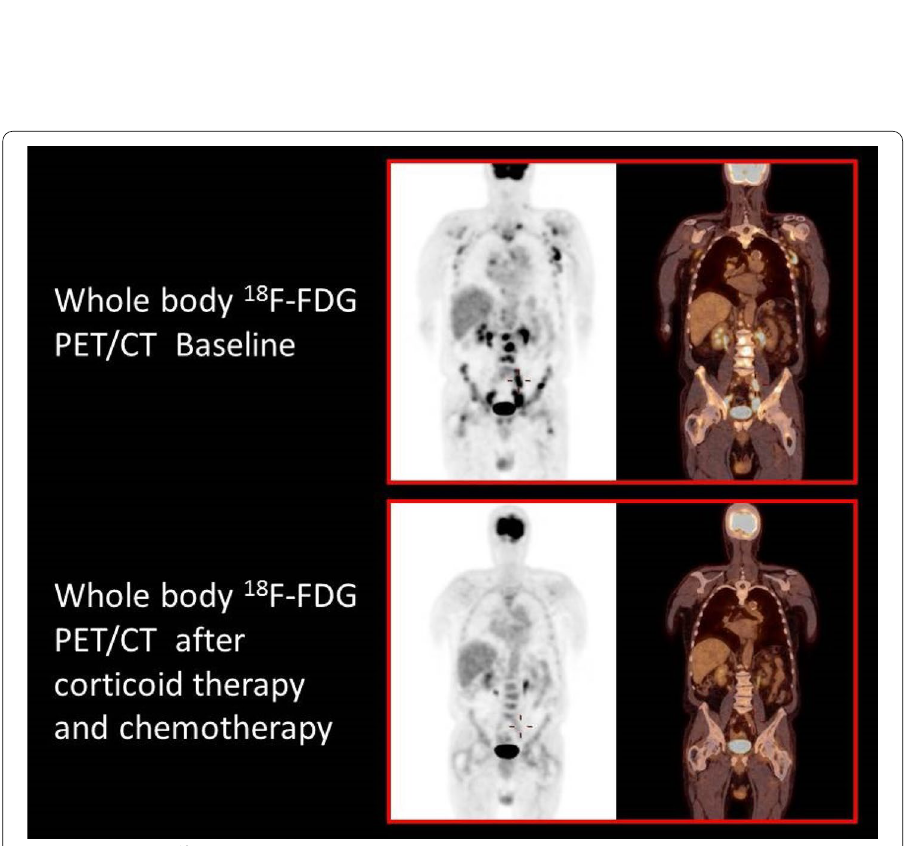
Fig. 4 Whole body 18 F-FDG PET/CT demonstrating a complete response after corticoid therapy, 6 cycles of R-CHOP, and 4 cycles of